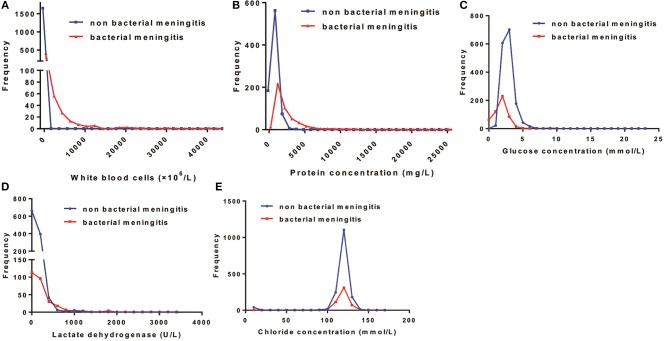
Distribution patterns of cerebrospinal fluid (CSF) parameters in the total bacterial and non-bacterial meningitis neonates. The distribution patterns of (A) white blood cells, (B) protein concentration, (C) glucose concentration, (D) lactate dehydrogenase, and (E) chloride concentration in neonates with and without bacterial meningitis.